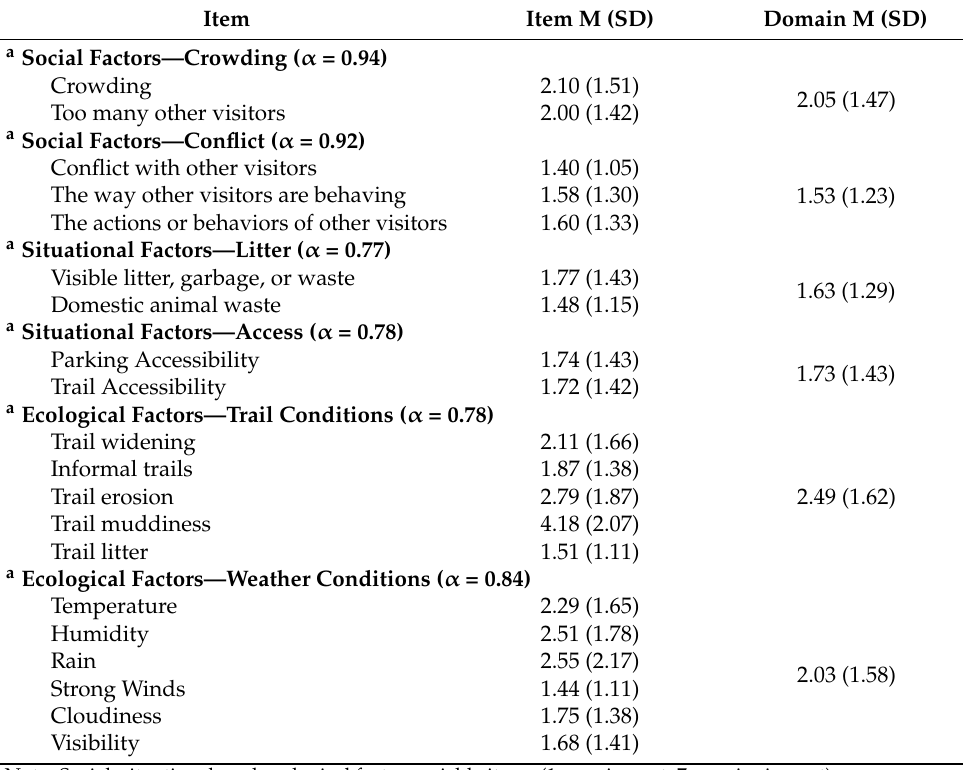
Table 1. LBW Visitors’ Perceived Social, Situational, and Ecological Impacts. Item M (SD) Domain M